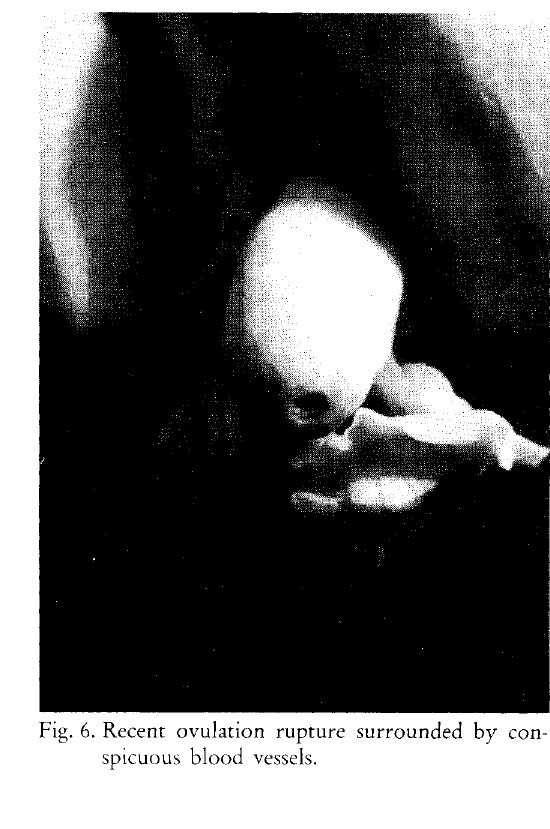
Fig. 6. Recent ovulation rupture surrounded by con spicuous blood